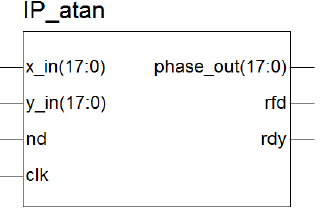
Figure 16. Interface diagram of the phase calculation module.